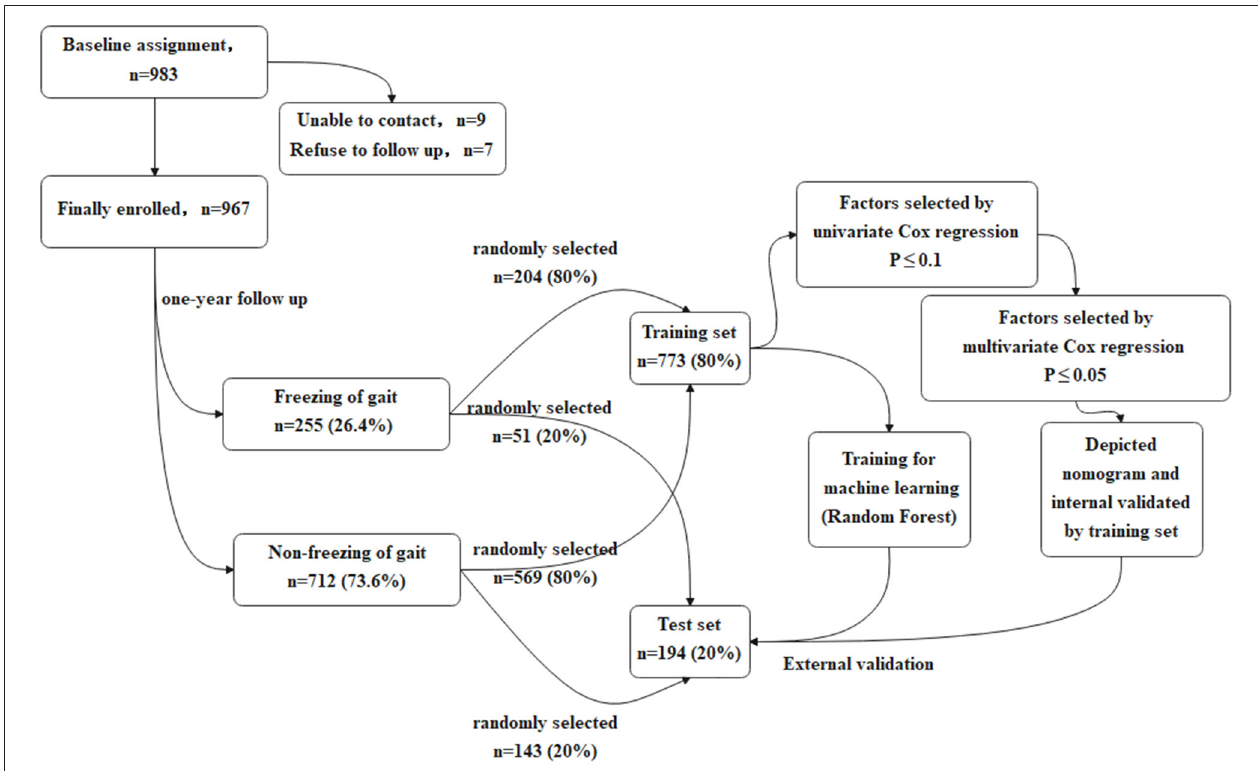
FIGURE 1 | The flow chart of the